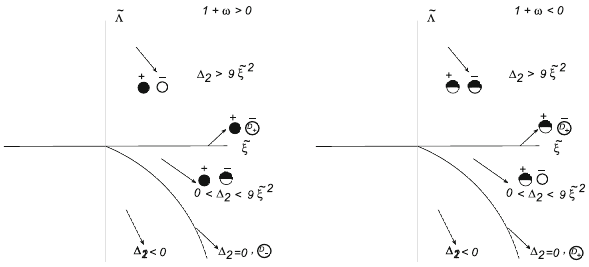
Fig. 16 The bifurcation diagram for all the five possible regions in the ( ˜ (cid:4), ˜ ξ) plane as divided by the solid curve, ˜ (cid:4) = − 3 the ˜ ξ axis. The hollow circle, solid circle and half-filled circle indicate respectively, an unstable (source) fixed point, a stable (sink) fixed point and a saddle. The circled D + denotes degenerate fixed point having one zero eigenvalue and one positive while the circled D − denotes degenerate fixed point having one zero eigenvalue and one negative eigenvalue. The + and − signs over the circles indicates that fixed point coordinates are given according to Eq.